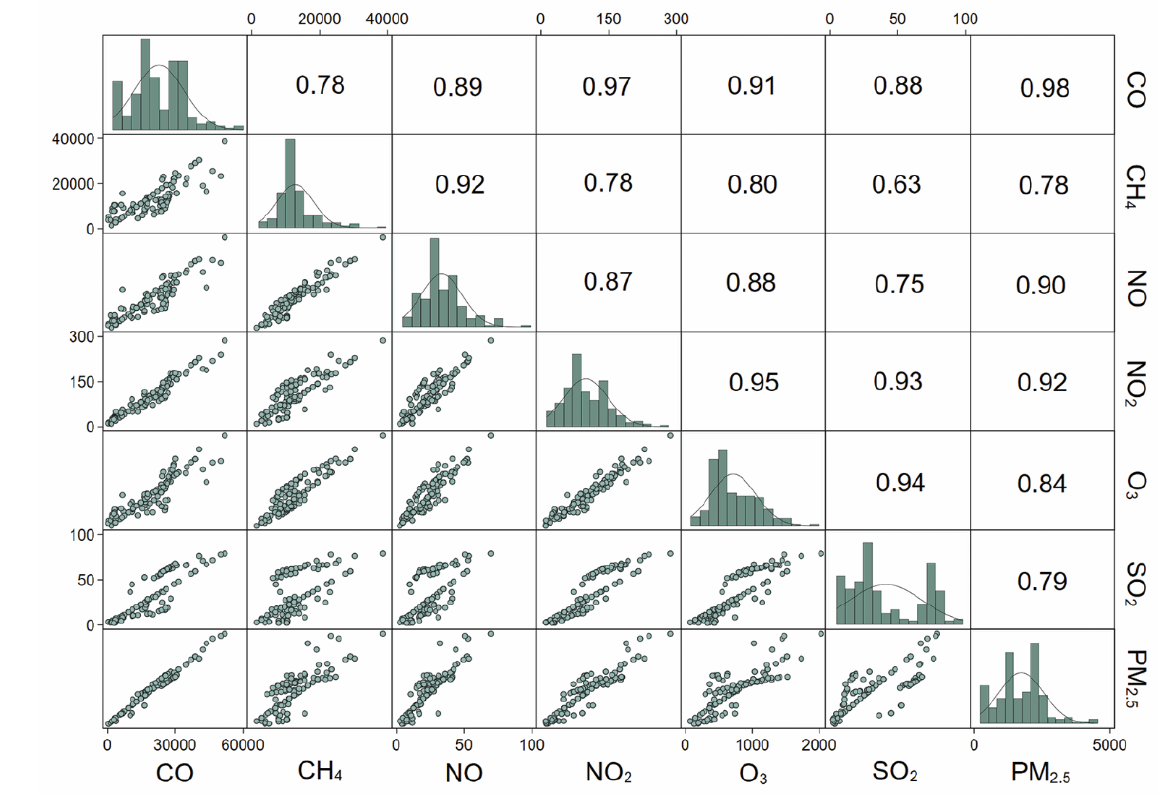
Figure 1. Scatterplot matrix and distribution (histograms) of continuous air pollution indices. Bivariate scatterplots of continuous variables below the diagonal; (distribution) histograms of each variable on the diagonal; Spearman’s correlation coefficient ( ρ ) above the diagonal. Note: All correlation values are significant at p < 0.001. Abbreviations: CO: carbon monoxide; CH 4 : methane; NO: nitric oxide; NO 2 : nitrogen dioxide; O 3 : ozone; SO 2 : sulfur dioxide; PM 2.5 : particulate matter ≤ 2.5 µ m in diameter. All units are in µ g/m 3 .